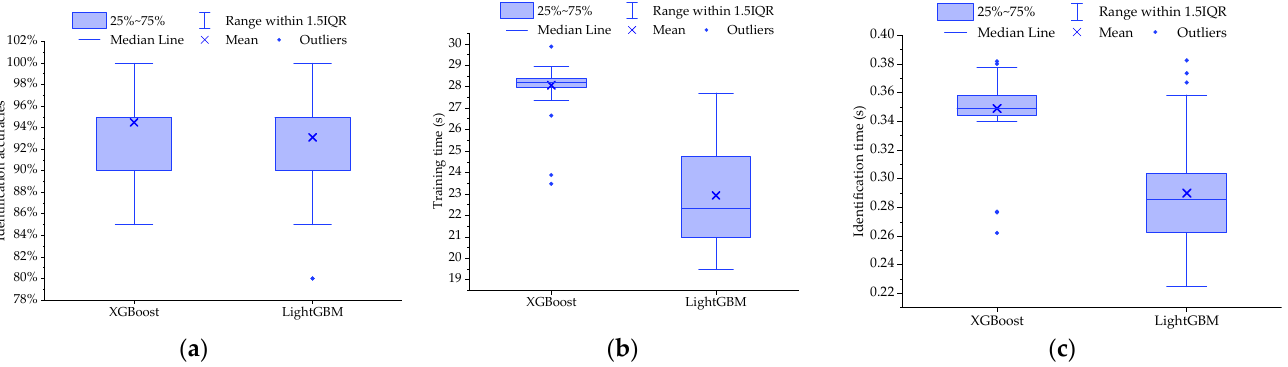
Figure 13. Statistical results obtained in liquor experiments. ( a ) Boxplot of the identification accuracies. ( b ) Boxplot of the time spent for training. ( c ) Boxplot of the time spent for prediction.